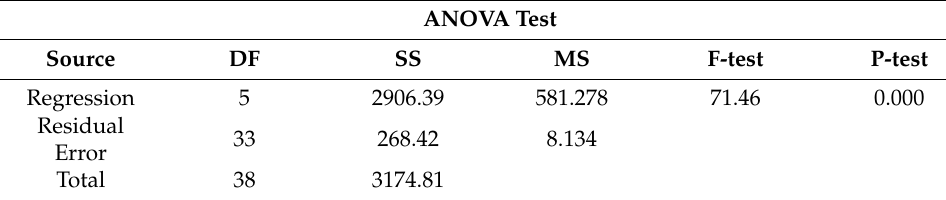
Table 7. Summary of the performance statistics for the PLS model—E u 50 .